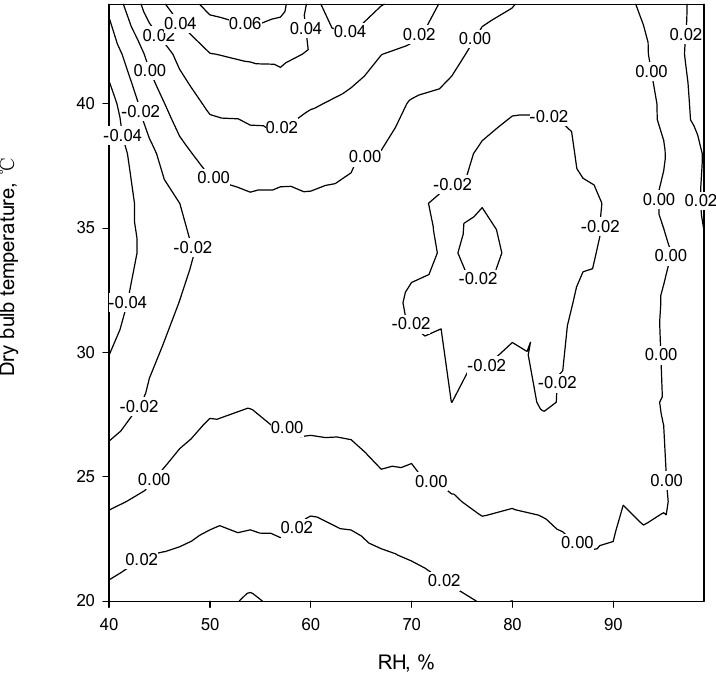
Figure 4. The error distribution for Model I.